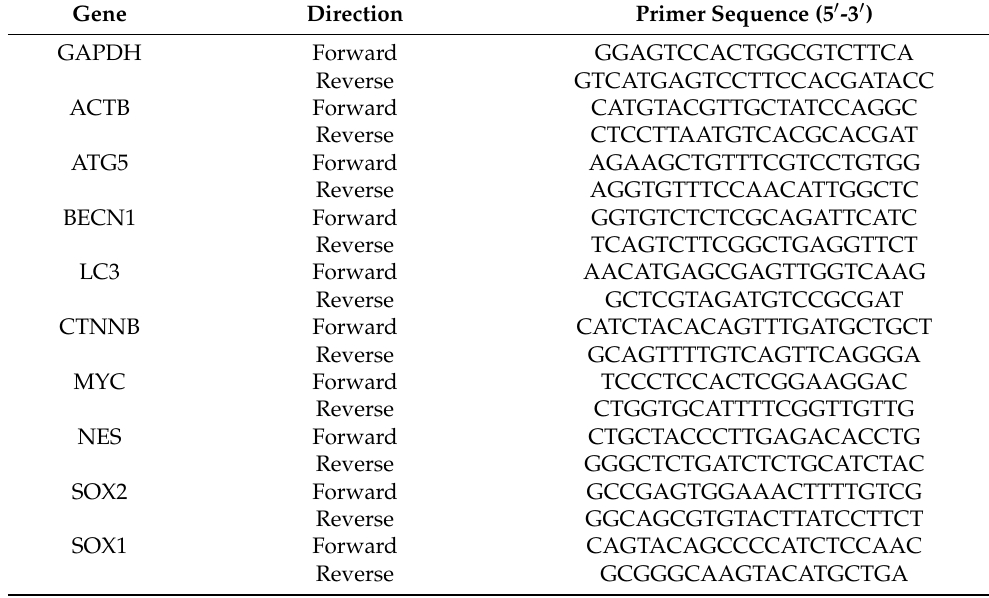
Table 1. Quantitative real-time polymerase chain reaction primer sequences. Gene